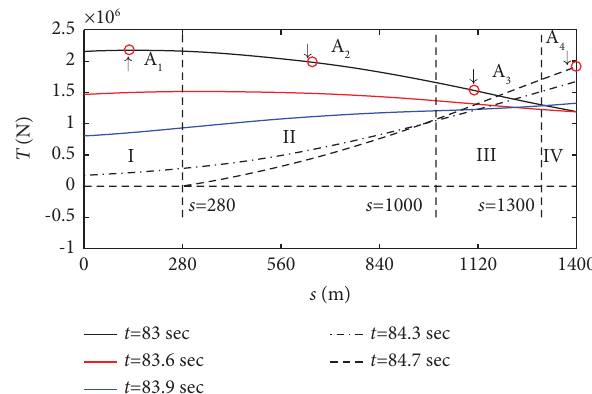
Figure 3: Tension distribution of mooring line at diferent